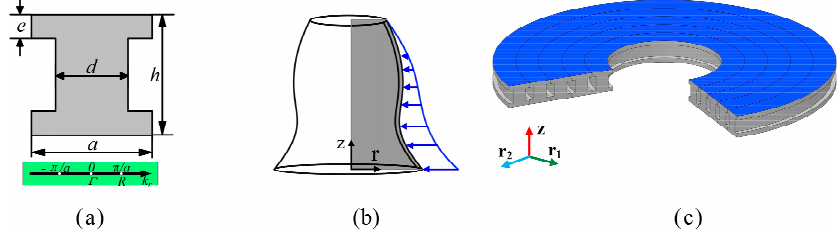
Figure 1. REM: ( a ) Schematic diagram of REM lattice structure and BZ wave vector (Gamma-R) in reciprocal space. ( b ) Formation of REM. ( c ) Quasi-static supermaterial.